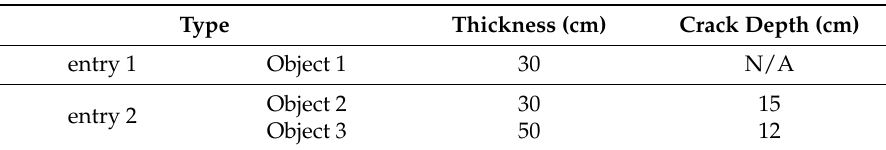
Table 1. Testing object